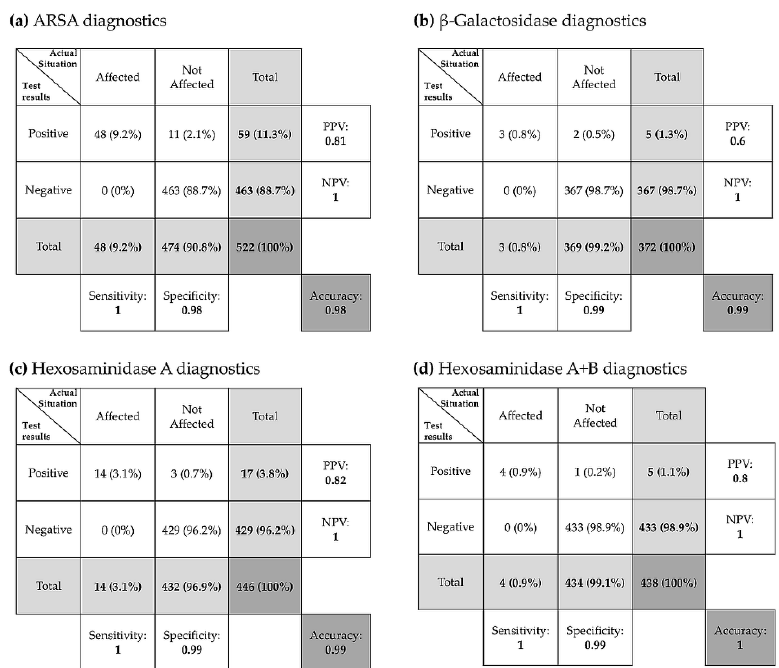
Figure 5. Contingency tables for ARSA, β -Gal, HEX A and HEX A + B diagnostics. With the help of contingency tables enzyme activity assays for arylsulfatase A (ARSA) ( a ), β -galactosidase ( b ), β -hexosaminidase A ( c ), and β -hexosaminidase A + B ( d ), were evaluated for their sensitivity, specificity, positive predictive value (PPV), negative predictive value (NPV) and accuracy.